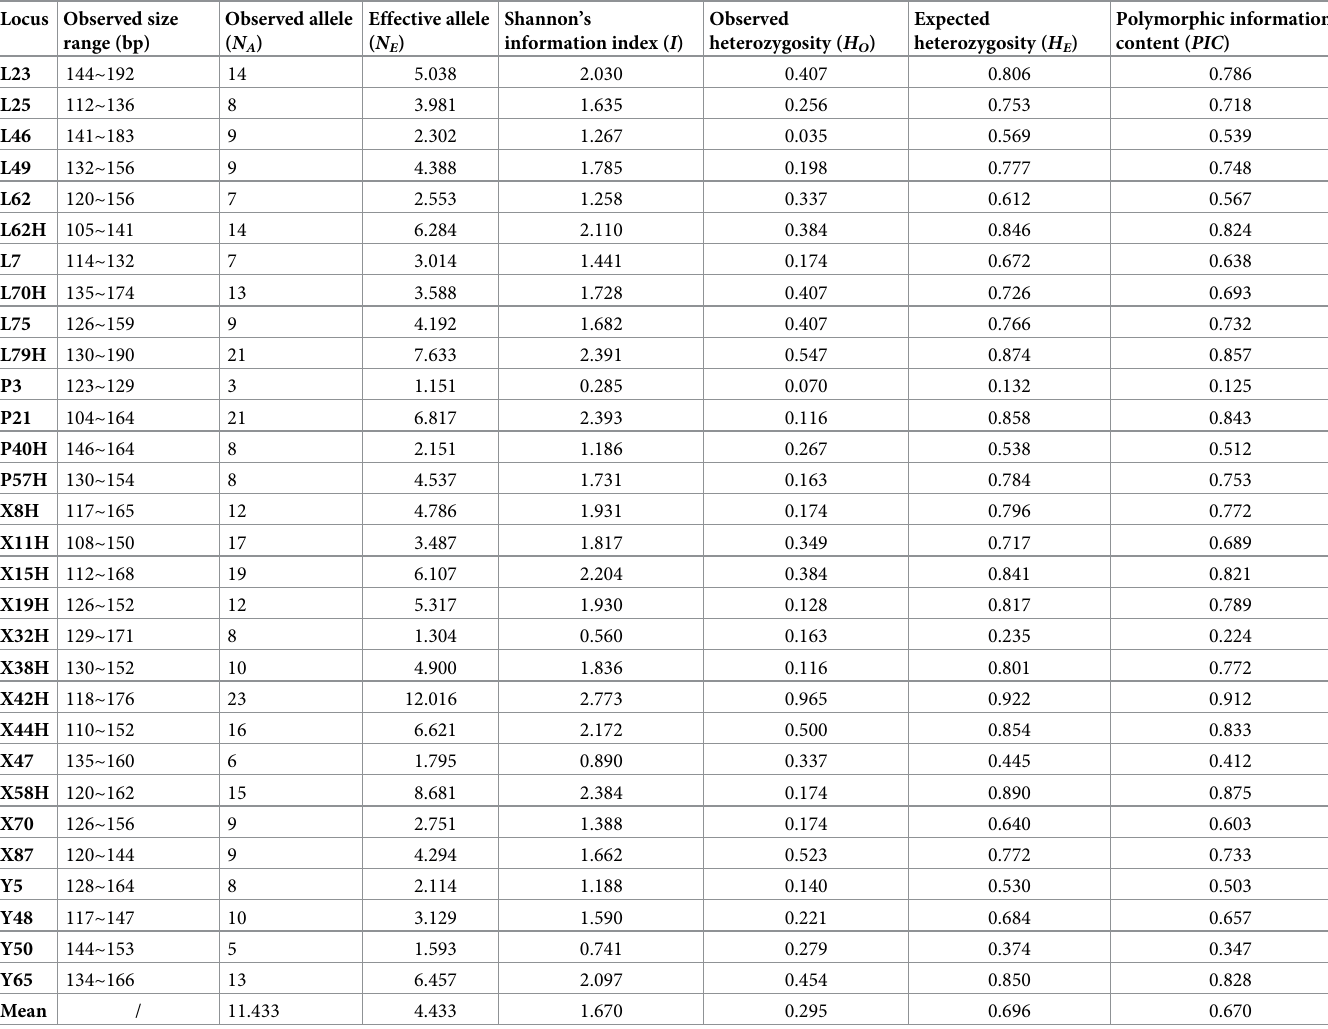
Table 1. Diversity of 30 SSR markers from P . armeniaca var. ansu